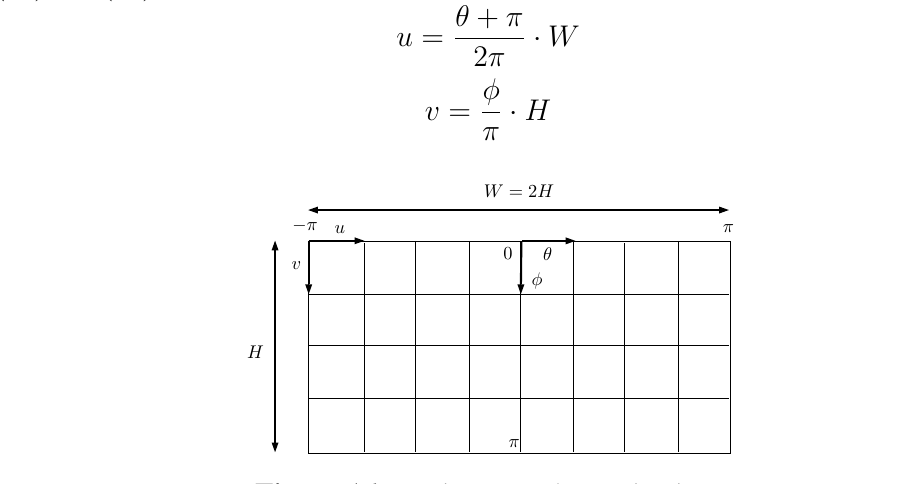
Figure 16. Equirectangular